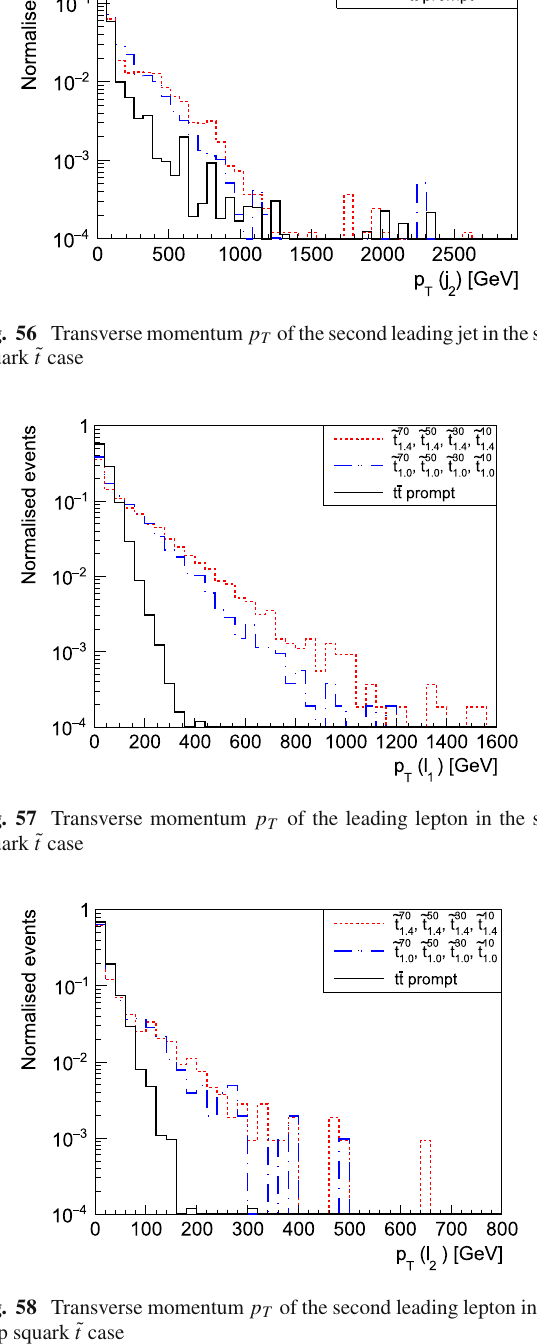
a non-negligible portion of jets merge into one single jet.